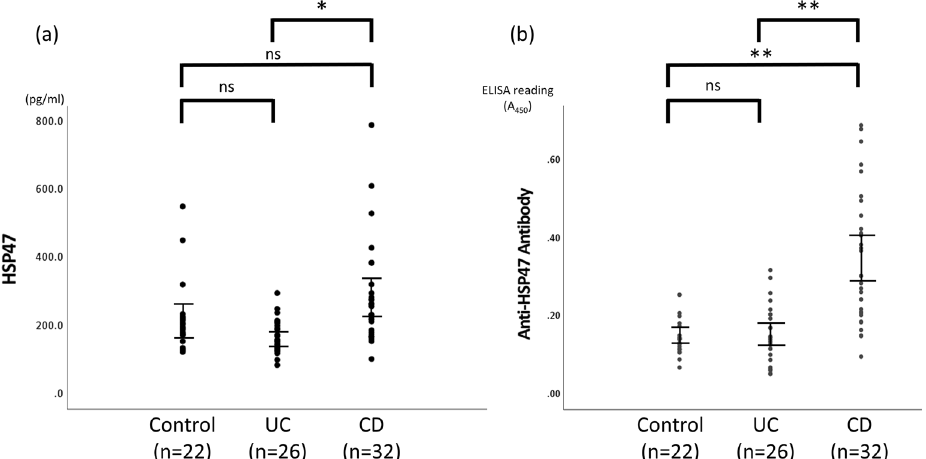
Figure 1. Comparison of serum HSP47 and anti-HSP47 antibody levels among control, UC, and CD groups. ( a ) Quantitative analysis of HSP47 levels in control (n = 22), UC (n = 26), and CD (n = 32) groups. ( b ) Quantitative analysis of anti-HSP47 antibody levels in control, UC, and CD groups. Each dot represents one subject, and bars indicate average ± SEM. *P < 0.001 (Dann–Bonferroni); **P < 0.001 (Scheffe test). HSP heat shock protein, UC ulcerative colitis, CD Crohn’s disease, ns not significant.